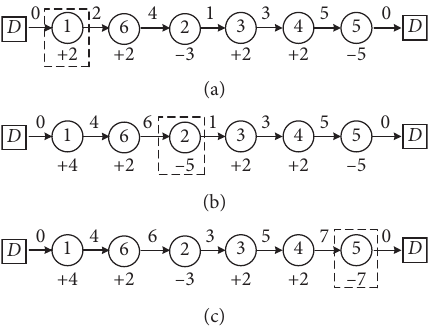
Figure 7: Feasible solutions after applying repair operator. (a) Adjustment of the loading quantities of station 1. (b) Adjustment of the unloading quantities of station 2. (c) Adjustment the unloading quantities of station 5.